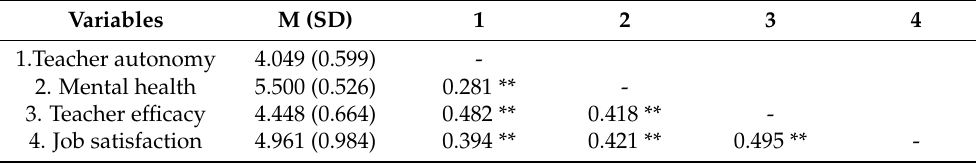
Table 1. Descriptive statistics and correlations among study